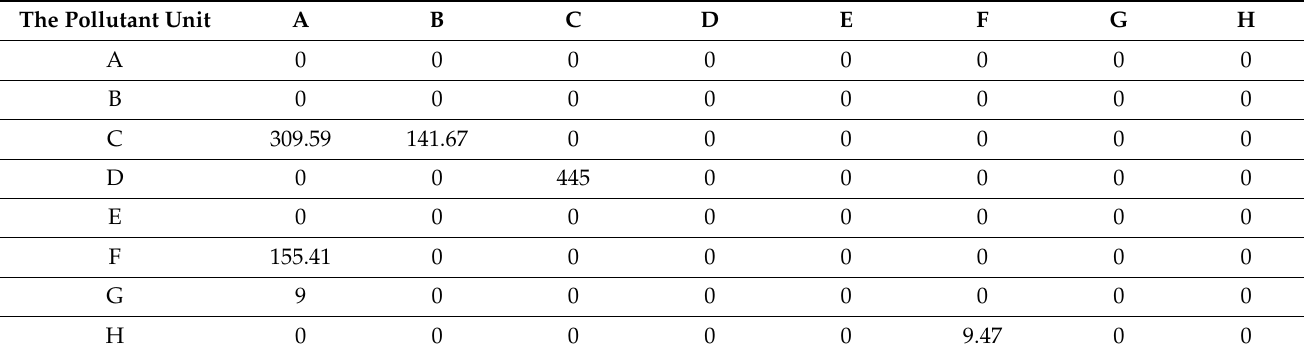
Table 3. The optimal value of trading discharge permits (tons/year).